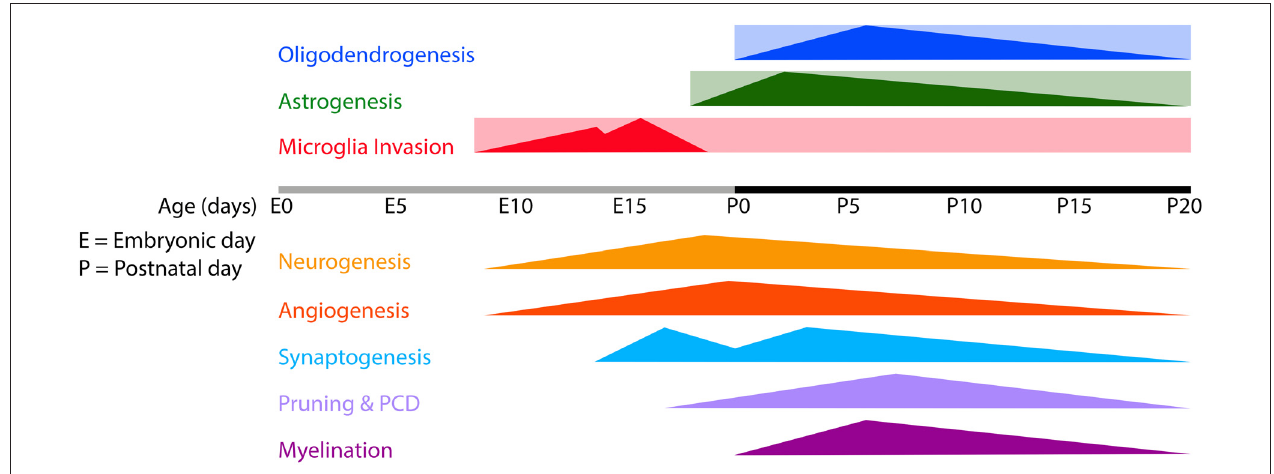
FIGURE 1 | Timeline of microglia invasion, gliogenesis and several developmental processes in the developing mouse brain. Rectangles indicate the estimated periods during/from which microglia, astrocytes and oligodendrocytes remain present in the brain. Triangles indicate the onset and peaks of the indicated developmental processes. Abbreviations: E, embryonic; P, postnatal; PCD, programmed cell death.